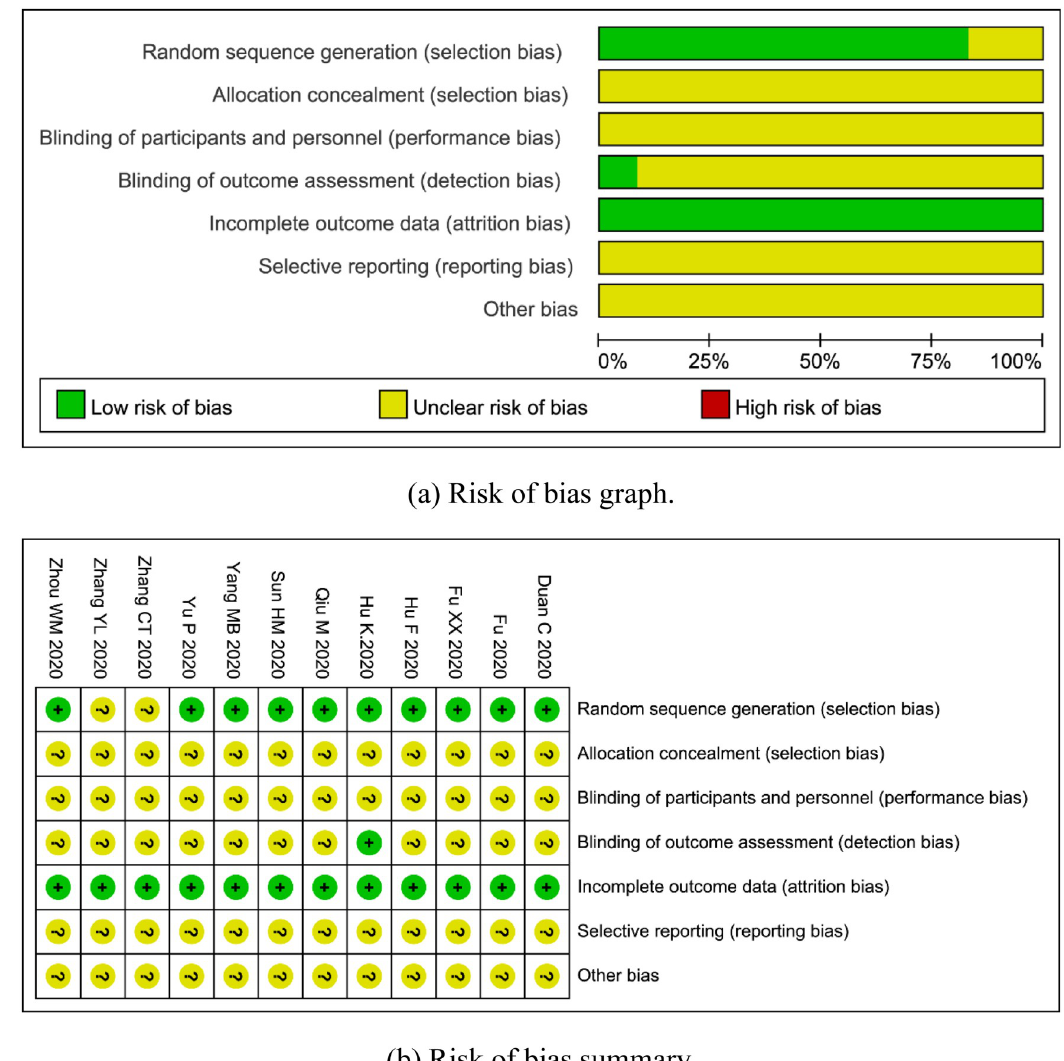
Fig 2. Assessment of methodological quality. (a) Risk of bias graph. (b) Risk of bias summary. enrolling 821 participants reported clinical cure rate [16, 17, 19, 22, 26]. A fixed-effects model was used due to no significant heterogeneity ( I 2 = 0%, P = 0.77). The outcome indicated clini- cal cure rate in combination therapy was higher than conventional therapy [RR = 1.26, 95%CI (1.16, 1.38), P < 0.00001] (Fig 3b). Rate of conversion to severe cases . Nine trials enrolling 1121 patients reported rate of conver- sion to severe cases [16–23, 25]. A fixed-effects model was used due to no significant heteroge- neity ( I 2 = 0%, P = 0.83). The results showed that combination therapy could significantly reduce rate of conversion to severe cases [RR = 0.48, 95%CI (0.32, 0.73), P = 0.0005] (Fig 3c). Viral nucleic acid testing . Negative rate of viral nucleic acid testing = (negative cases at the end of the trial − negative cases before the trial)/total cases × 100%. Four trials enrolling 581 patients reported viral nucleic acid testing [18–19, 22, 25]. A random-effects model was used due to the significant heterogeneity ( I 2 = 57%, P = 0.08). Meta-analyses revealed no statistical difference in viral nucleic acid testing [RR = 1.09, 95%CI (0.98, 1.21), P = 0.13] (Fig 3d).